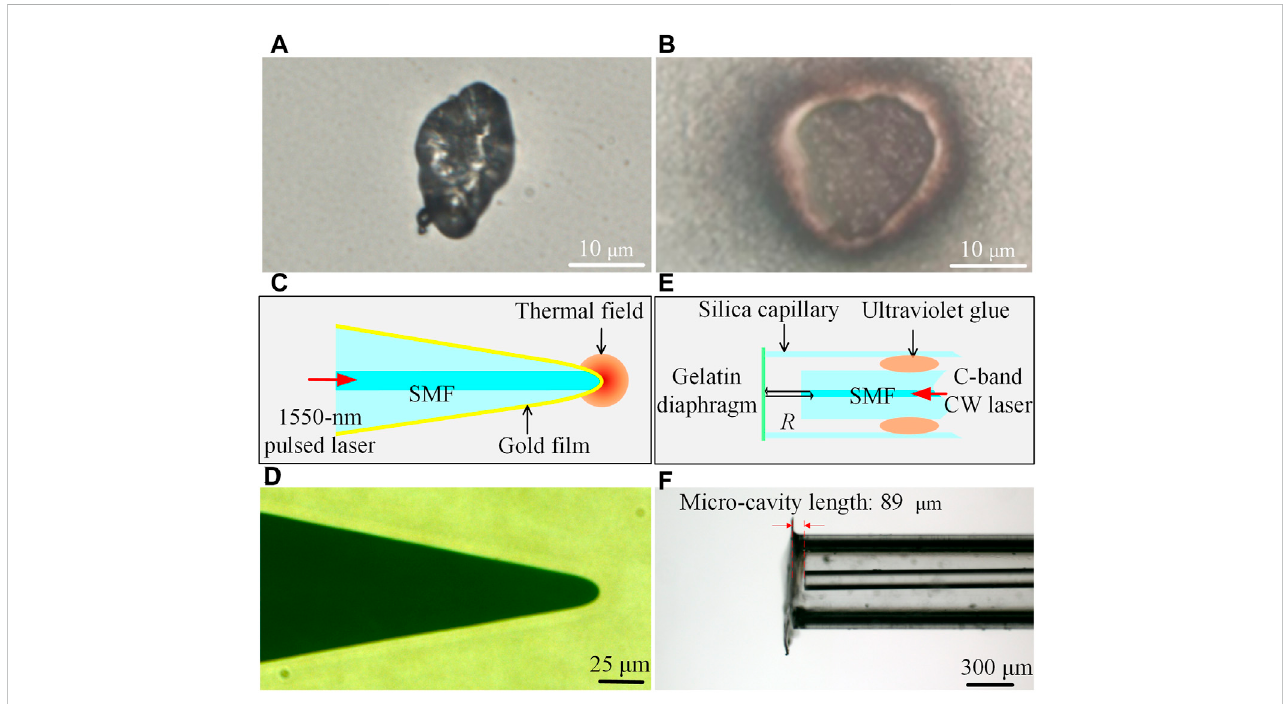
Preparation of the materials. (A) An uncoated micron-RDX particle. (B) A micron-RDX particle coated with coated nano-Al. (C) Schematic of the fi ber probe. (D) Picture of the fi ber probe. (E) Schematic of the fi ber F-P sensor. (F) Picture of the fi ber F-P sensor. The micro-cavity length is 89 μ m.